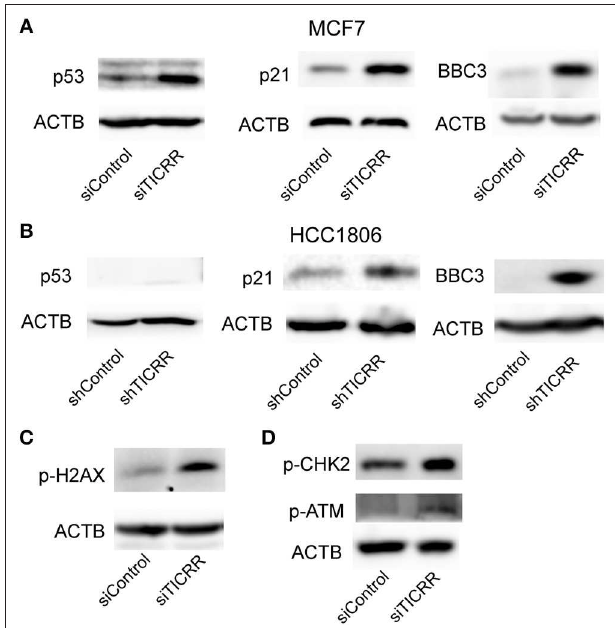
FIGURE 8 | Knockdown of TICRR activated ATM/CHK2-dependent p53 signal pathway. (A) Protein levels of p53, p21 and BBC3 in control and TICRR -knockdown MCF7 cells. N = 3 biological replicates. (B) Protein levels of p53, p21, and BBC3 in control and TICRR -knockdown HCC1806 cells. N = 3 biological replicates. (C) The p-H2AX protein in MCF7 cancer cells after transfection with siRNA for 8h. N = 3 biological replicates. (D) Protein levels of p-CHK2 and p-ATM in control and TICRR -knockdown MCF7 cells. N = 3 biological